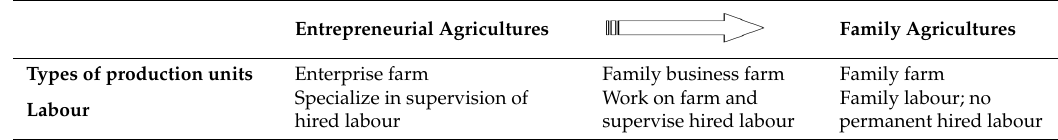
Table 2. Types of models of agricultural production units [23,24].